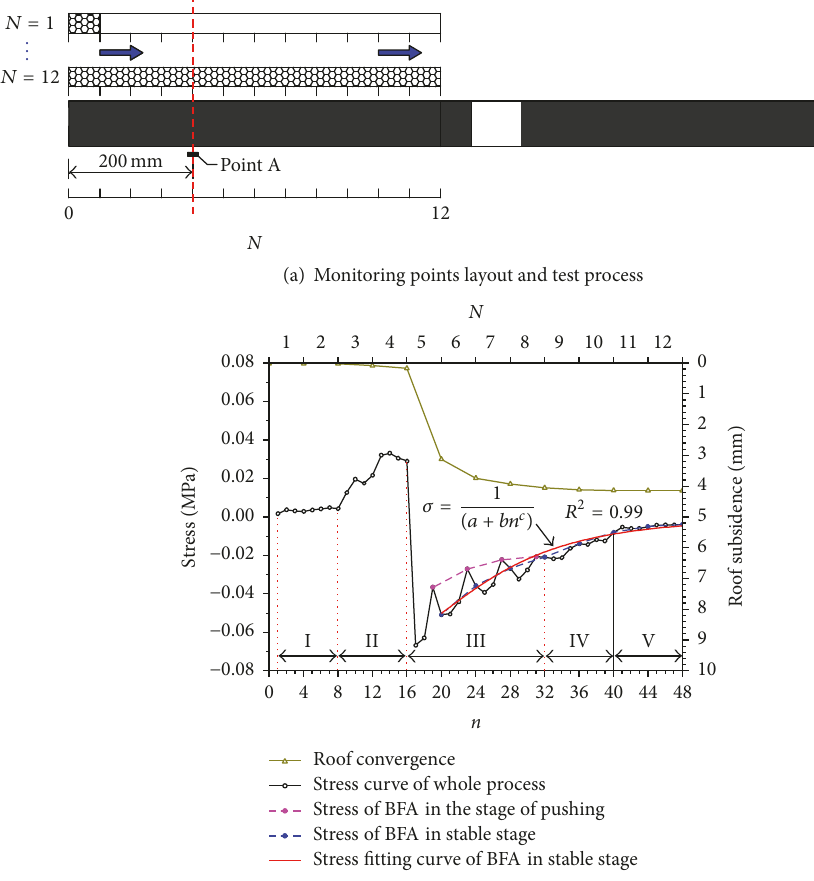
Figure 9: Monitoring point stress and displacement evolution process during model excavation.